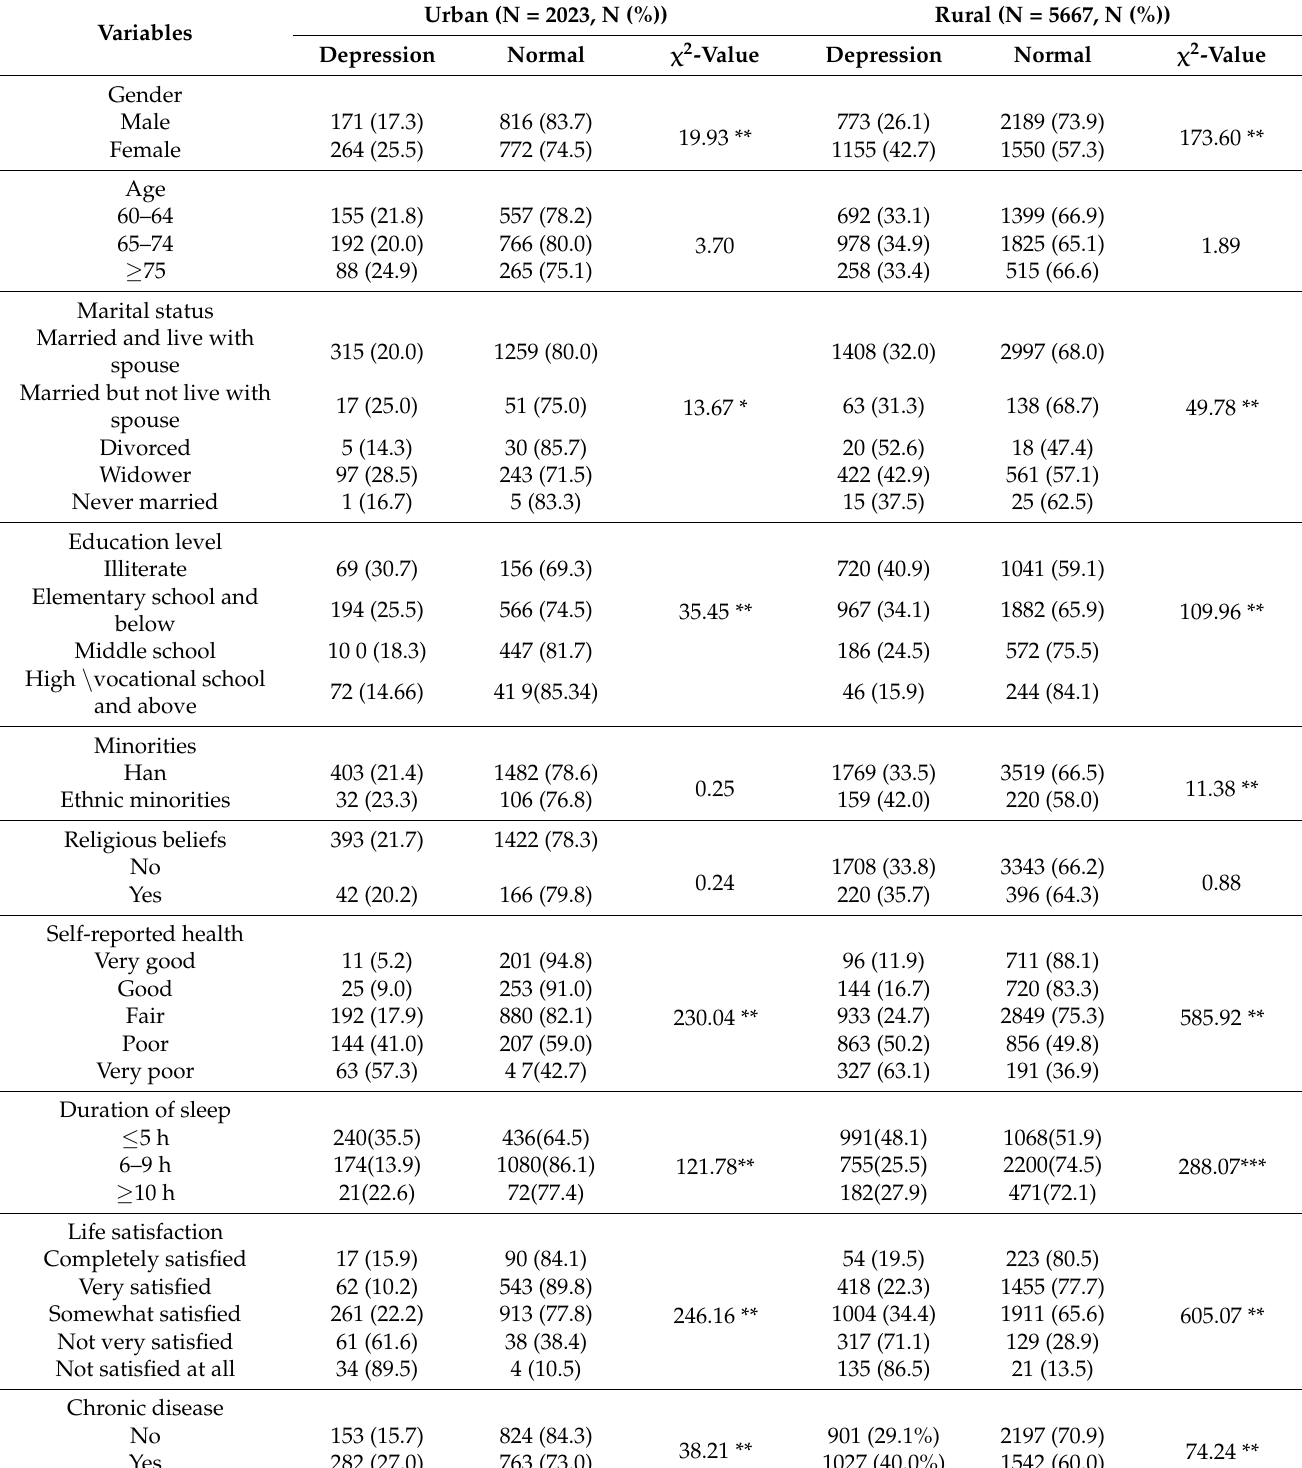
Table 4. Prevalence of depressive symptoms according to sociodemographic and health variables, urban and rural areas.